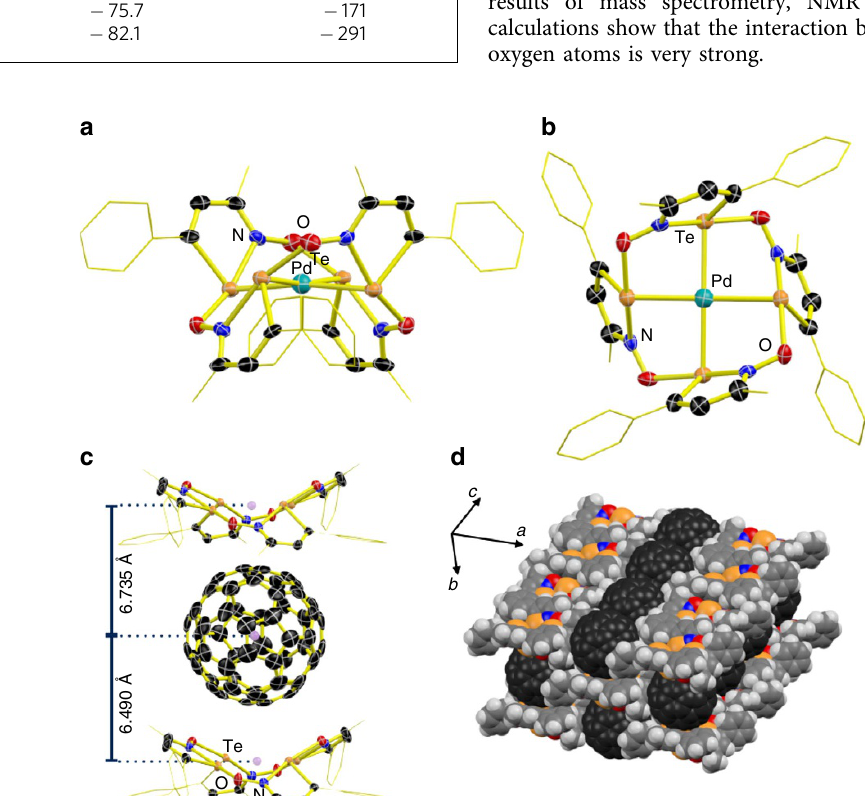
Figure 6 | Detail of the crystal structures of the derivatives of the macrocyclic tetramer 1b 4 . ( a , b ) ORTEP perspectives of the [Pd( 1b 4 )] 2 þ complex along (0,1,0) and along (2,1,0), respectively. ( c ) ORTEP of the crystal structure of 1b 4 (cid:3) C 60 . All displacement ellipsoids are shown at 75% probability. ( d ) Space-filling depiction of molecular packing the same crystal.